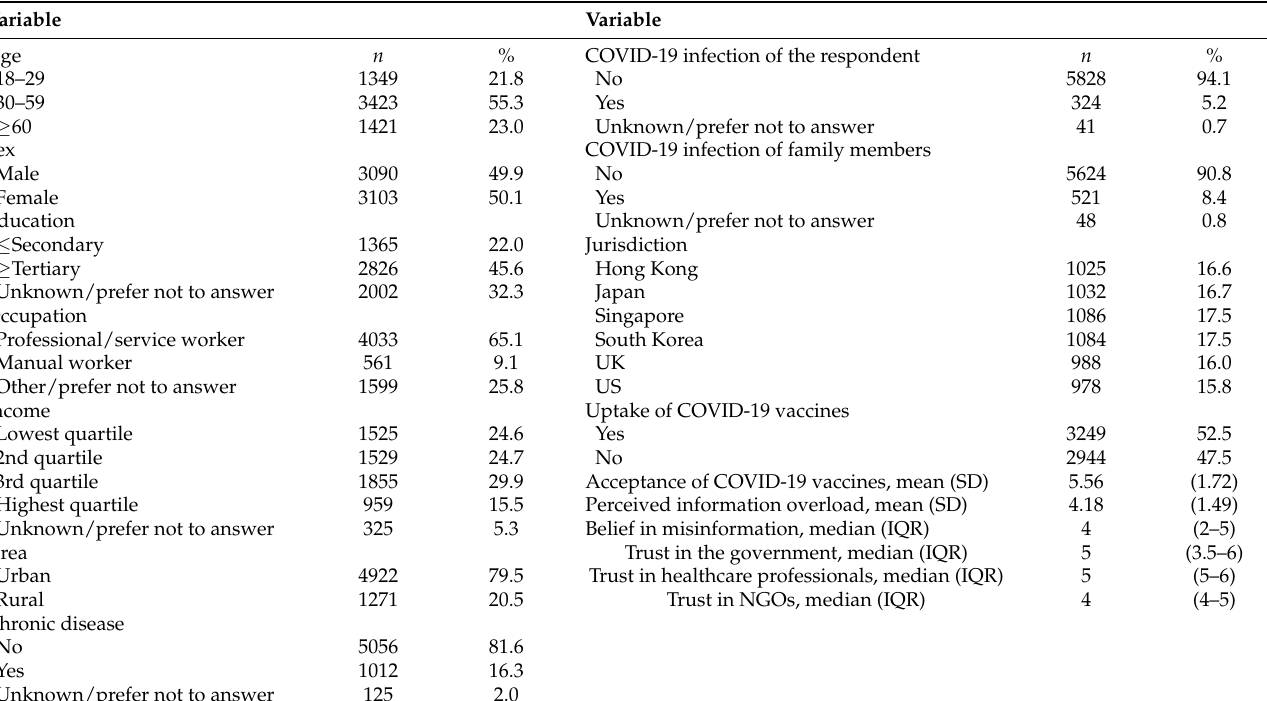
Table 1. Sample characteristics ( n =